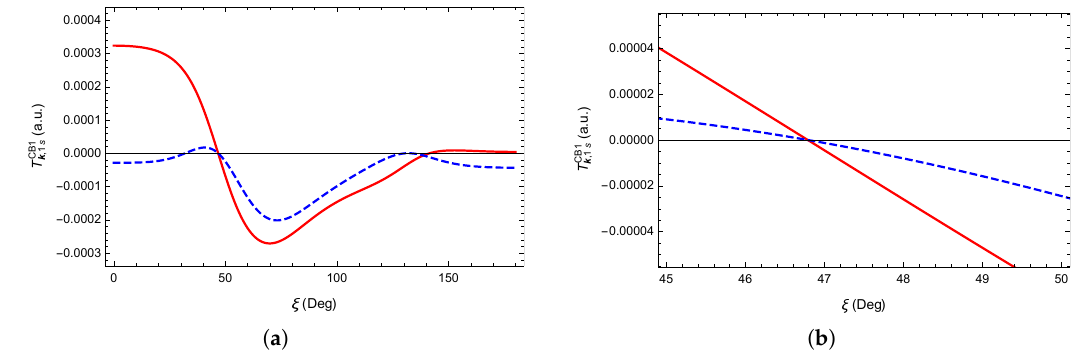
Figure 5. Transition matrix element T CB1 hydrogen at 100 eV with a gun angle, ψ , of 56.13 ◦ . ( a ) Re [ T CB1 blue line) over the full angular range ( b ) Re [ T CB1 the vicinity of the zero in T CB1